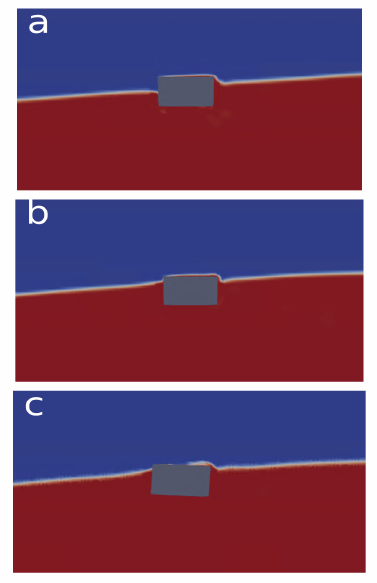
Fig. 9. Wave overtopping for the WEC moving (a) only in heave, (b) in heave and surge DoF, (c) in heave, surge, and pitch DoF. The phenomenon is more intense for the case with 2 DoF motion, but the introduction of the pitch motion slightly eliminates the wave